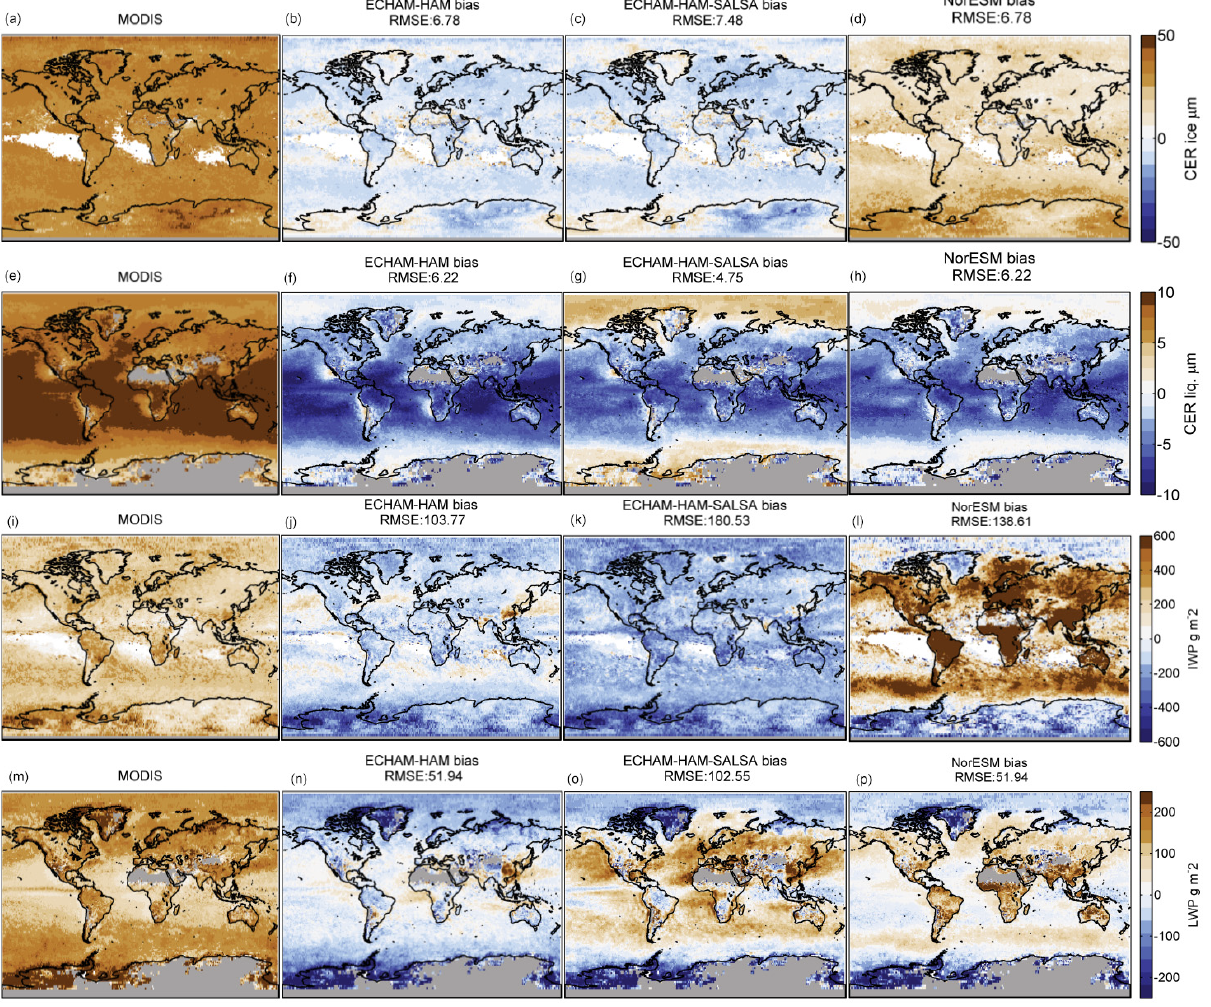
Figure 2. Annual global mean bias in cloud effective radius and water path. The bias represents the difference calculated by subtracting MODIS observation to MODIS-COSP diagnostics from ECHAM-HAM, ECHAM-HAM-SALSA, and NorESM. Ice cloud effective radius (CER ice ) from MODIS-COSP is compared with MODIS observations in (b) – (d) and liquid cloud effective radius (CER liq ) in (f) – (h) . The biases related to the comparison of COSP-simulated ice water path (IWP) are showed in (j) – (l) and for liquid water path (LWP) in (n) – (p) . Pixels with liquid cloud fraction ≤ 30% are screened. The averages represent in-cloud values. Pixels with liquid cloud fraction ≤ 30% are screened. Values are in-cloud concentrations. High latitudes (lat > 60 ◦ N or lat > 60 ◦ S) are excluded in the computation of the root mean square error (RMSE). MODIS spatial distribution is presented as reference (a, e, i, m)